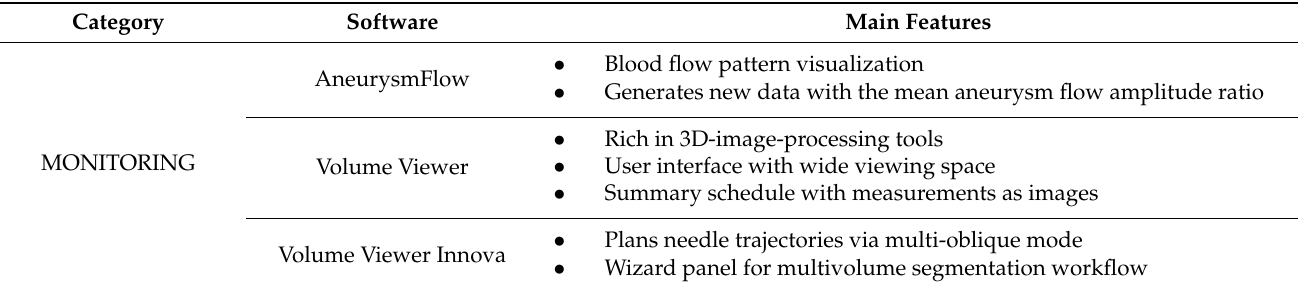
Table 3. Summary of commonly available (MONITORING) procedural software used in interven- tional